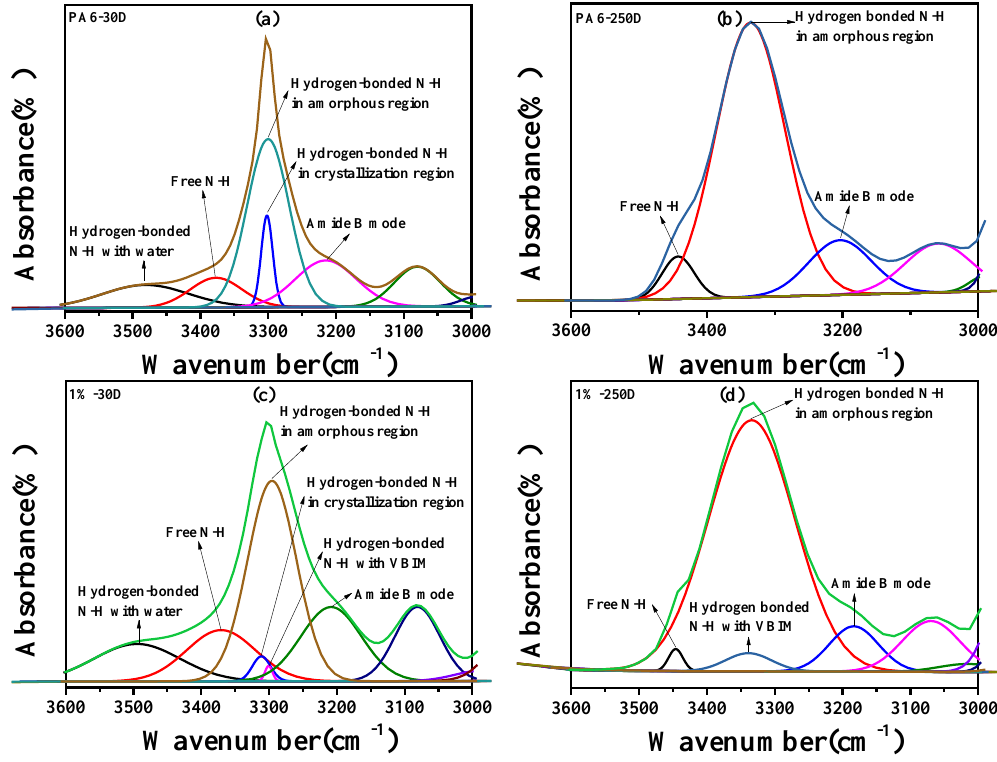
Figure 10. Curve-fitting of the N–H stretching band of ( a ) PA6 at room temperature; ( b ) PA6 at 250 °C; ( c ) PA6/VBIM, 1 wt % blend at room temperature; and ( d ) the PA6/VBIM, 1 wt % blend at 250 °C.